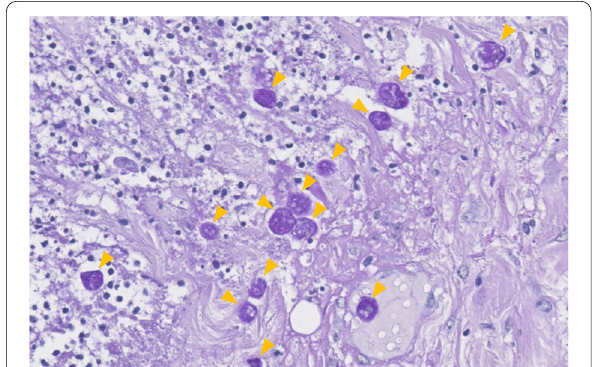
Fig. 4 Histopathological findings in the resected colon. Massive amoebae invasion was observed using periodic acid–Schiff